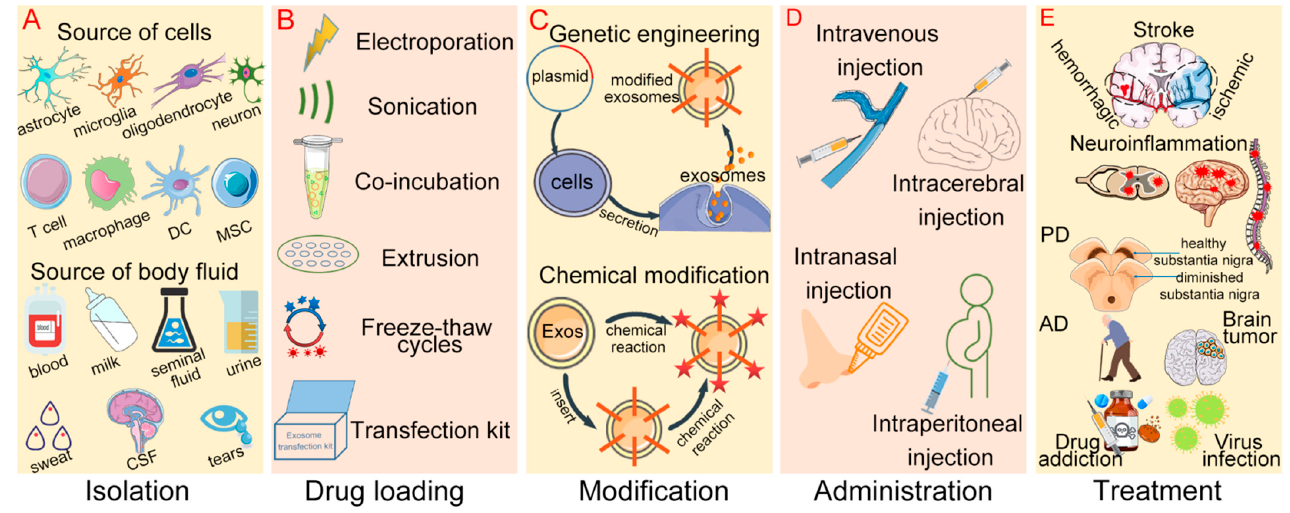
Figure 4. The research process of exosomes as CNS drug delivery tools. ( A ) Exosomes are isolated from cells or body fluids; ( B ) multiple drug loading modes of exosomes; ( C ) exosomes can be modified by genetic engineering and chemical reactions; ( D ) several administration routes of cargo-loading exosomes; ( E ) exosomes loaded with therapeutic molecules are used to treat a variety of CNS diseases. DC: dendritic cell; MSC: mesenchymal stem cell; CSF: cerebrospinal fluid; Exos: